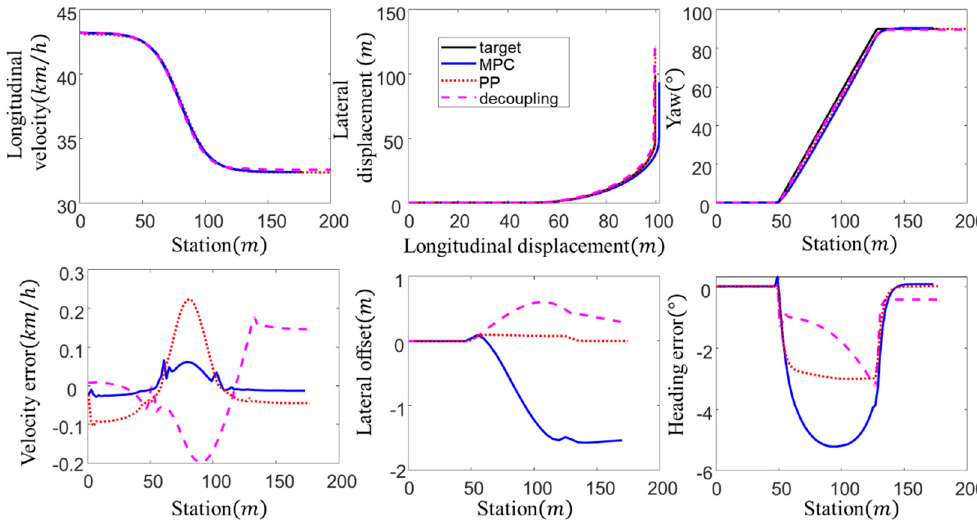
Figure 9. Trajectory tracking results in scenario 2.